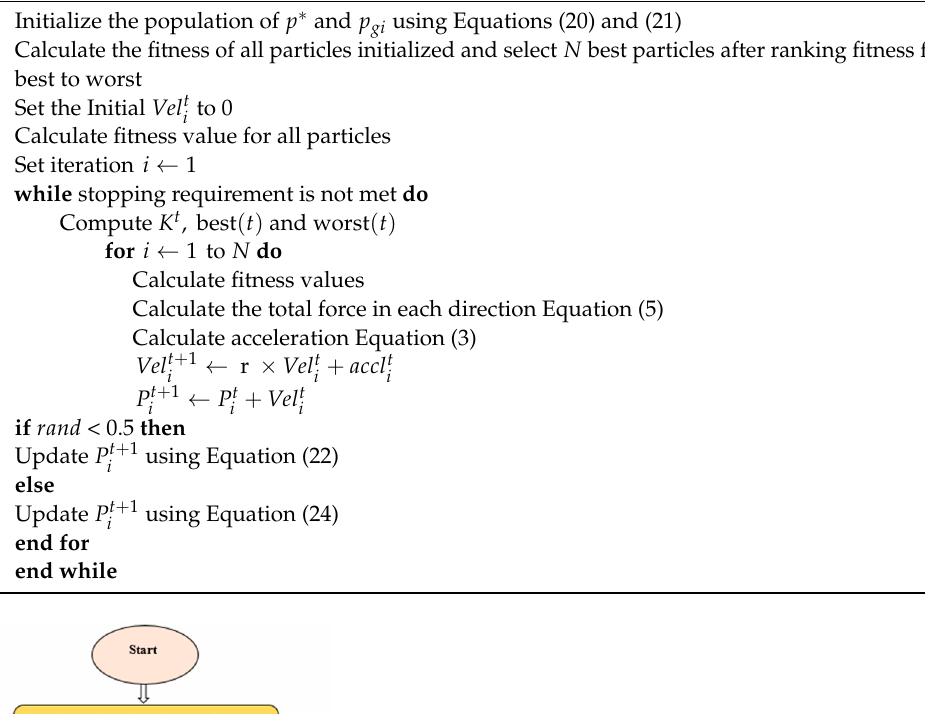
Algorithm 2 and Figure 3 show the pseudocode and the flowchart of GSLEO-AEFA, respectively. The method begins with the population initialization using SRL and then uses GM to further increase the population diversity. The LEO is placed afterwards to improve the position of each particle. Algorithm 2 Gaussian Mutation Specular Reflection Learning with Local Escaping Operator Based Artificial Electric Field Algorithm (GSLEO-AEFA)